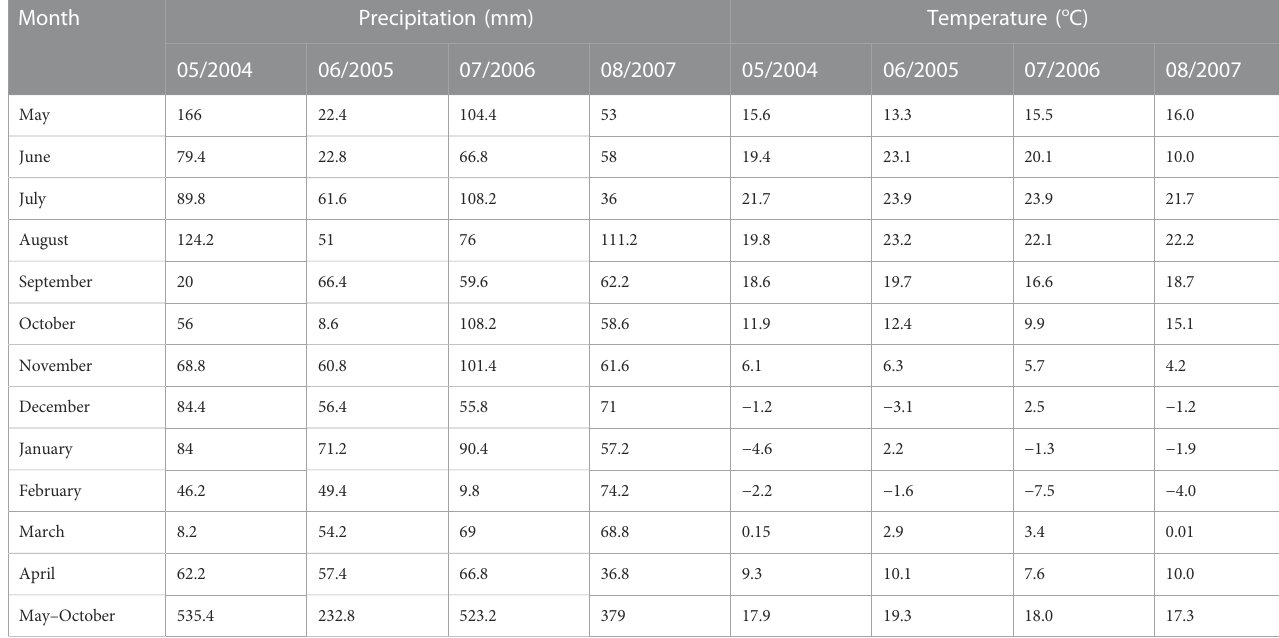
TABLE 1 Monthly and growing season ’ s means of precipitation and temperature at the study site, Woodslee, ON, Canada. Month Precipitation (mm)